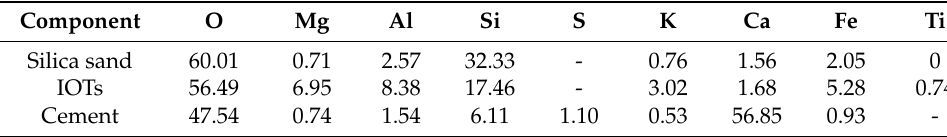
Table 2. The elemental compositions of natural sand and IOTs.